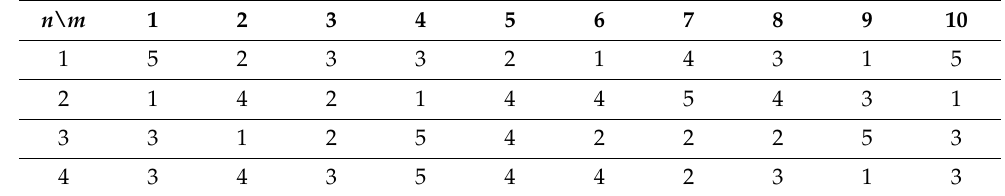
Table 2. Four initial tracks with 10 dimensions, and the building has five elevators. n \